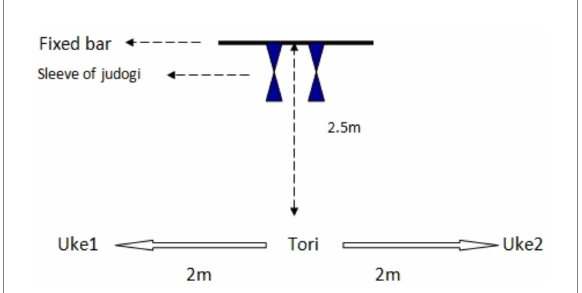
FIGURE 1 Uchi-komi Fitness Test schematic representation (Almansba et al.,